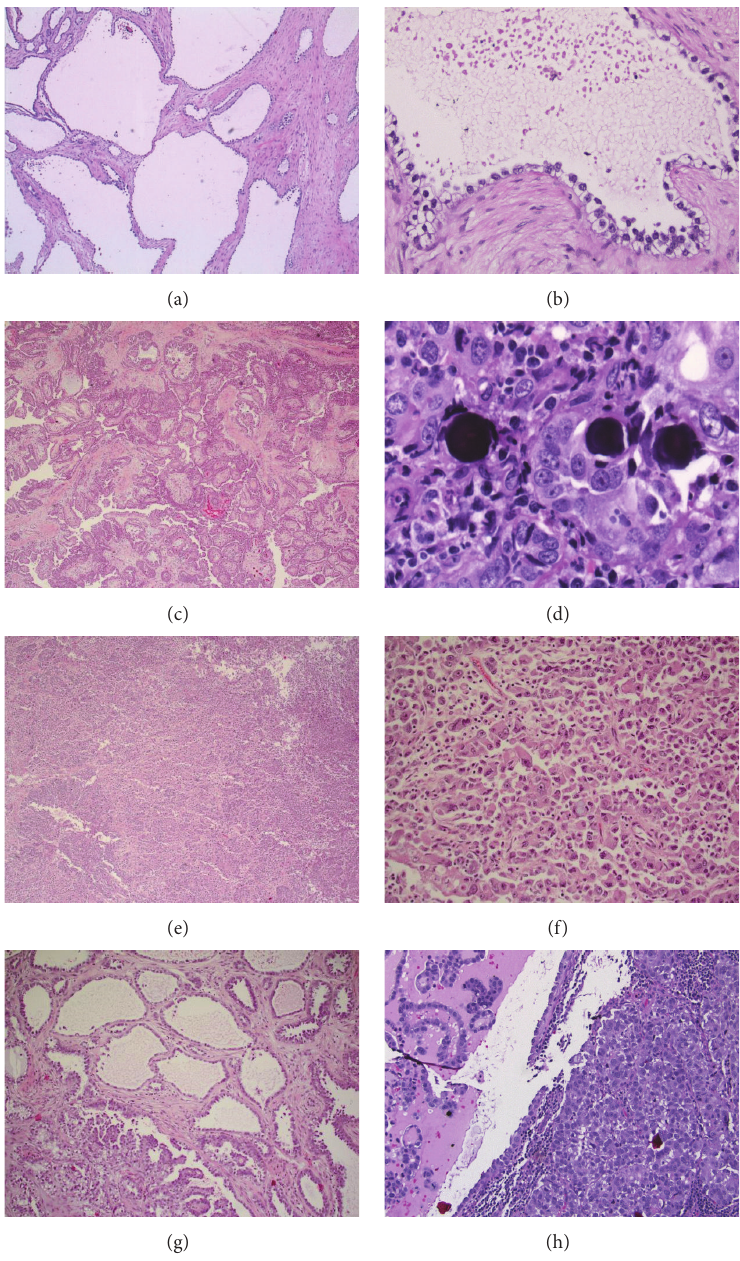
Figure 5: The tumor demonstrated a spectrum of serous neoplasia, with areas of serous cystadenoma representing the better differentiated component (a, b), papillary serous carcinoma with numerous Psammoma bodies representing the areas of high grade tumor (c, d), and solid sheets of poorly differentiated tumor cells representing the dedifferentiated component (e, f). These morphologic features were those of serous neoplasia with progressive dedifferentiation. Transition zones were present (g, h) (hematoxylin-eosin staining; (a), (c), (e), and (g) 40x; (b) 400x; (d) 600x; (f) 200x; (h)